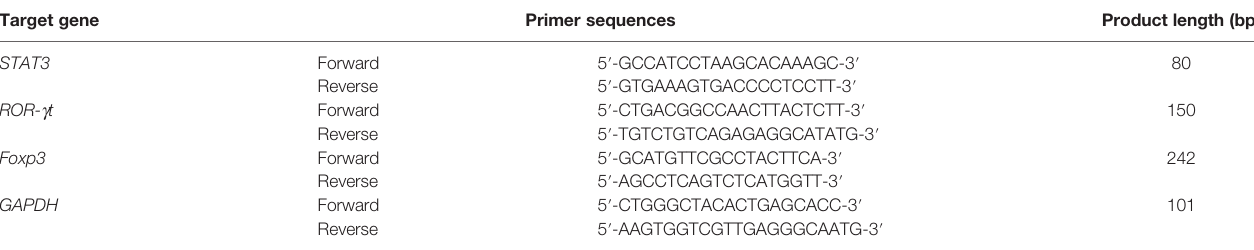
TABLE 1 | Primer sequences for quantitative real-time PCR (qRT-PCR). Target